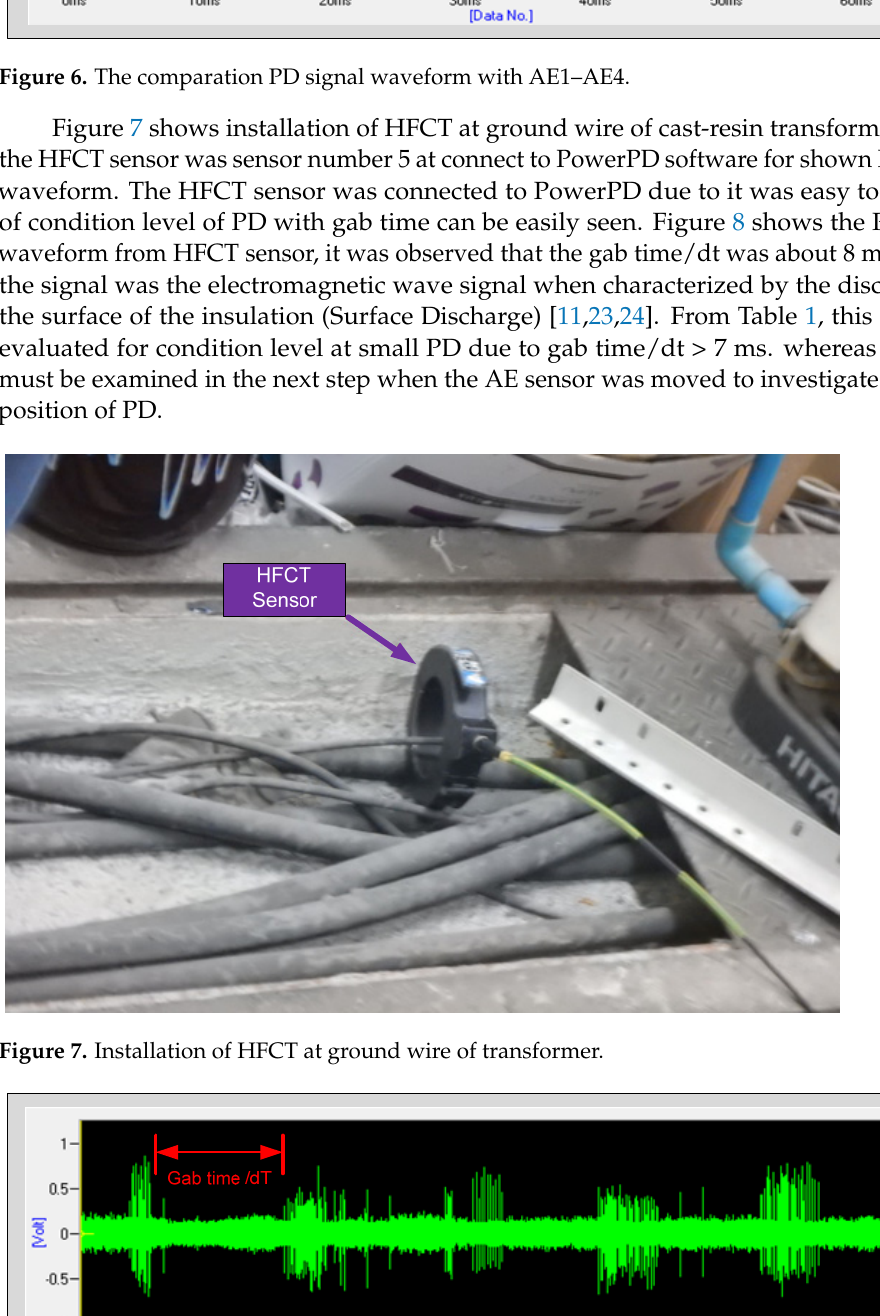
Figure 7. installation of HFCT at ground wire of transformer.